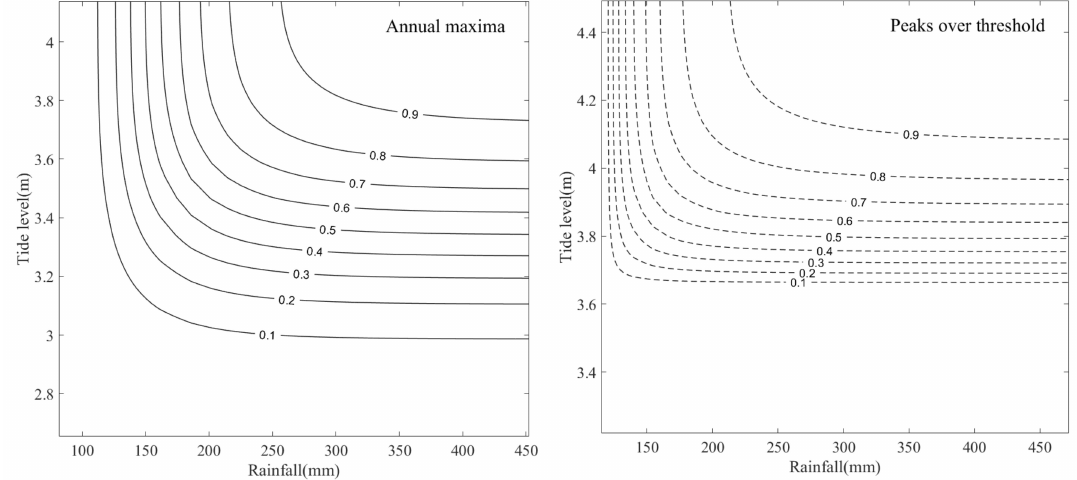
Figure 7. Contour lines of joint exceeding probabilities calculated using GEV and gamma marginal distributions for extreme rainfall and corresponding high tide levels obtained using two sampling